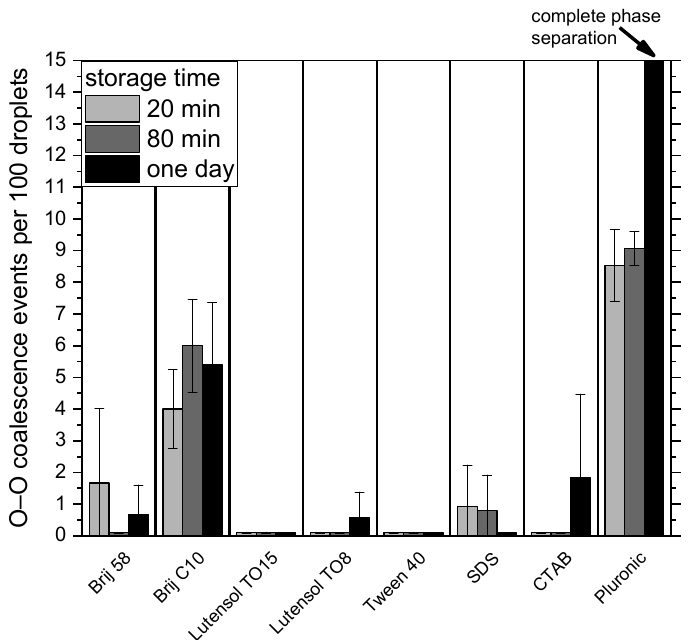
Figure 4. Number of O–O coalescence events normalized to 100 droplets with 0.9 wt% of different hydrophilic surfactants in W 2 and 1 wt% of PGPR in O. Double emulsions with Brij C10 and Pluronic show most oil droplet coalescence, the other samples are comparatively stable. With Tween 40 and Lutensol TO15, the emulsions show not a single coalesced oil droplet for all storage times investigated. For Brij C10 and Pluronic, significant coalescence of oil droplets was observed. With 4 to 7 coalescence events per 100 droplets with Brij C10 and between 7 and 10 with Pluronic, clear trends are seen. While the Brij C10 emulsion was, after one day, still stable enough to measure droplet sizes, Pluronic stabilized W 1 /O/W 2 double emulsion droplets separated completely in a W 1 /O emulsion and W 2 phase. The reason for Brij C10 being more instable than the other short chain surfactants can be found in its low HLB value of 2.7. It is the most lipophilic alcohol ethoxylate examined and is therefore less suitable for the stabilization of O/W